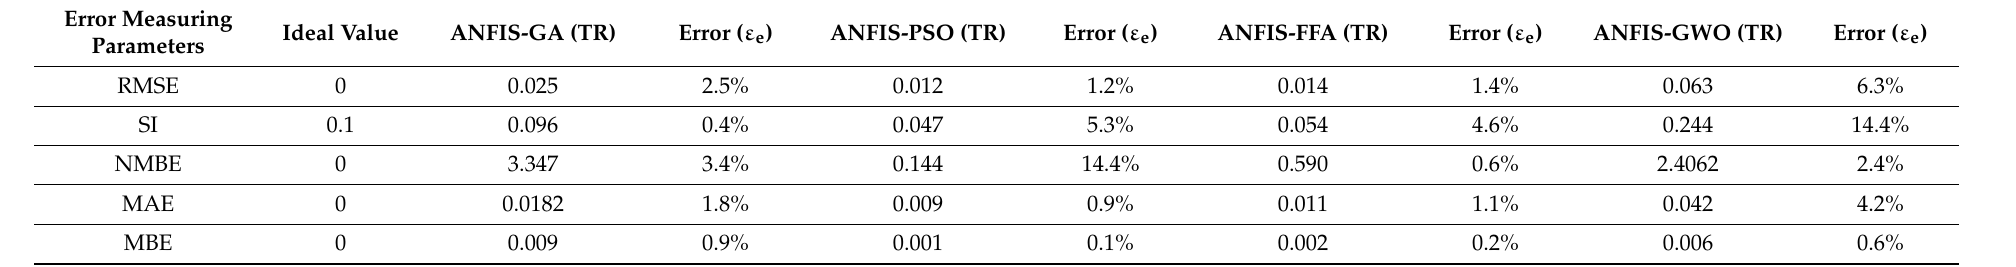
Table 6. Computed error for error measuring parameters (training dataset).